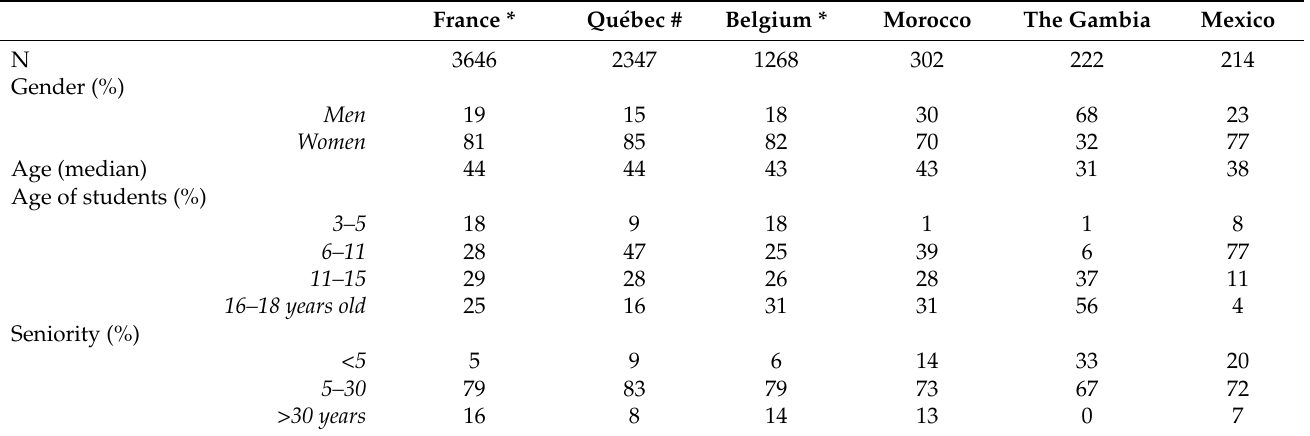
Table 1. Characteristics * of teachers participating in the 2021 International Barometer of Education Personnel’s Health and Wellbeing